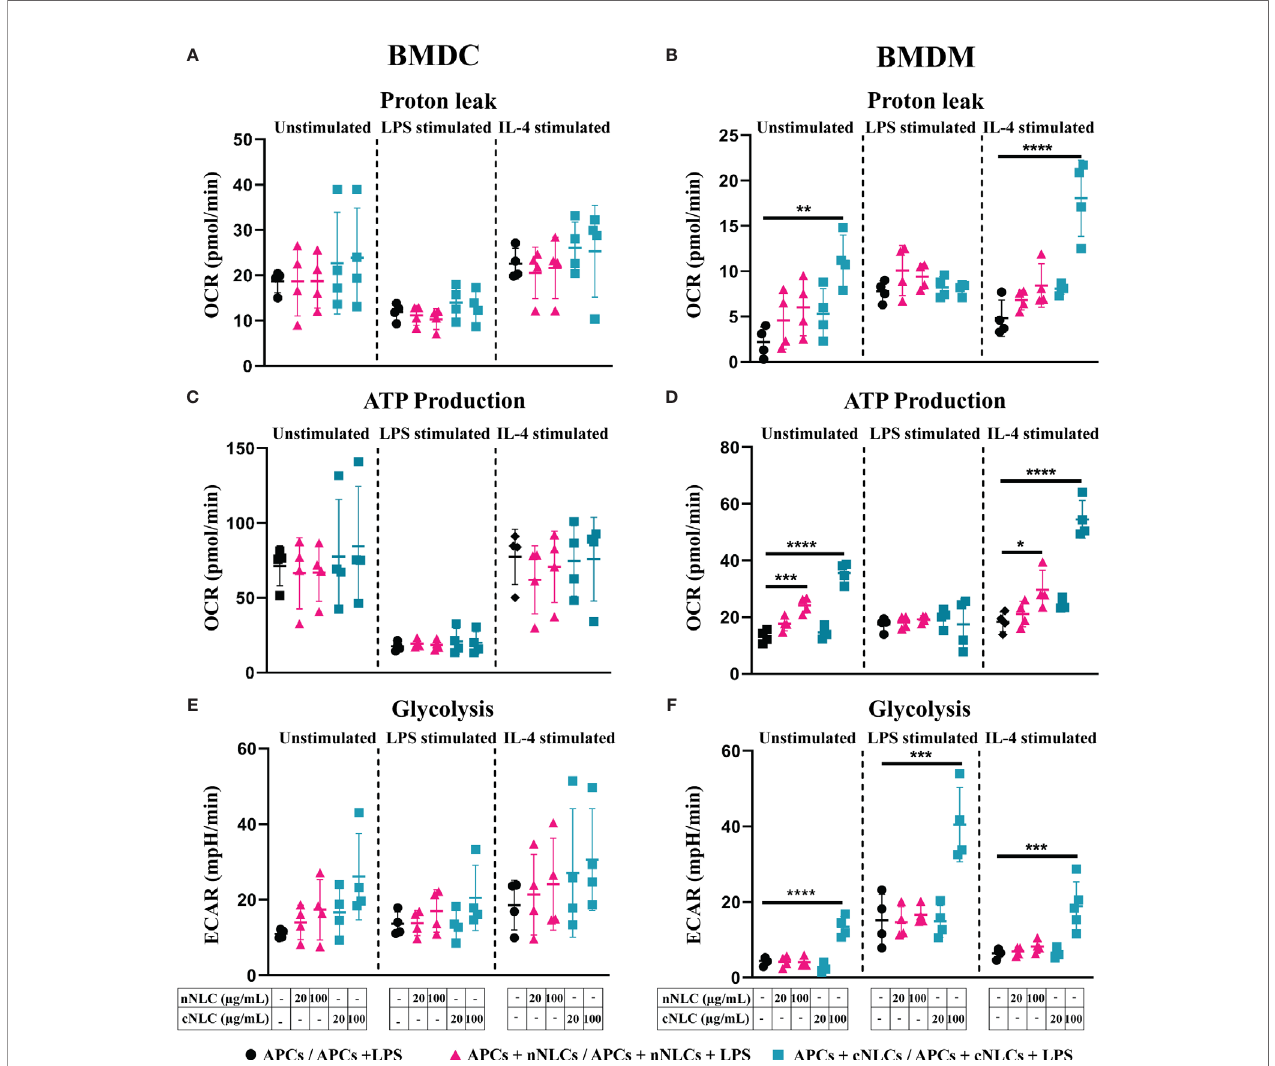
FIGURE 5 | Mitochondrial metabolism in naïve, classically activated or alternatively activated APCs in response to nNLCs or cNLCs. (A, B) Proton leak, (C, D) ATP production and (E, F) glycolysis in BMDCs and BMDMs, respectively, were measured after exposure to cNLCs or nNLCs for 24 h and activated by LPS or IL-4 for another 24 h. Oxygen consumption rate (OCR) and ECAR were quanti fi ed using a seahorse XF analyser. Data were normalised by cell number based on cell count (Hoechst 33342 staining) and are displayed as mean ± SD (N = 4 independent experiments). The statistical signi fi cance between nanocarrier treated or untreated groups was performed by one-way ANOVA test using Tukey ’ s multiple comparisons test. *P ≤ 0.05; **P ≤ 0.01; ***P ≤ 0.001; and ****P ≤